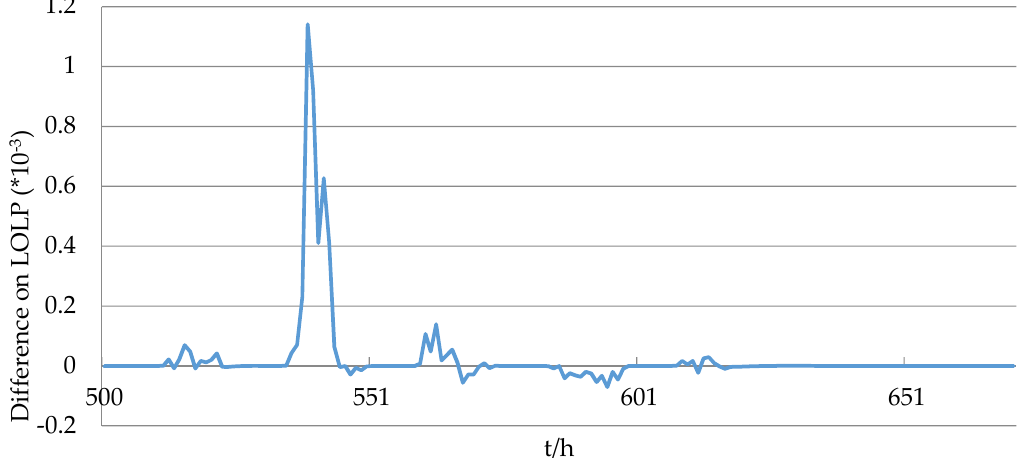
Figure 4. Difference on loss of load probability (LOLP) whether correlation is considered.